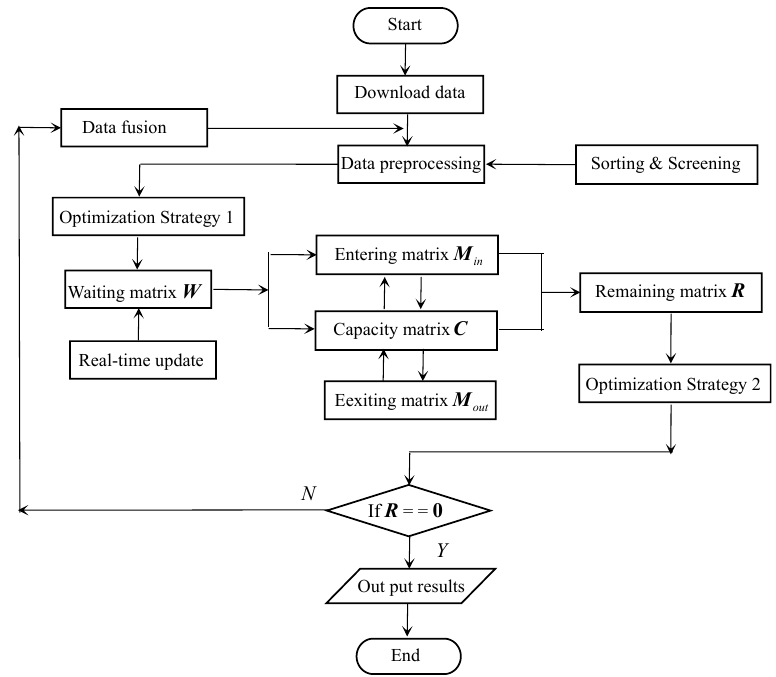
Figure 3. Reservation elevator internal data structure relational